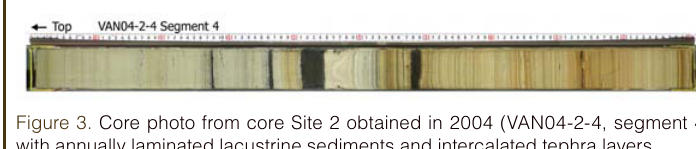
Figure 2. Stack (top) and part of Geochirp Profile GeoB04-007 (bottom) across the Tat-Van Basin. The ages for the ash layers are taken from Landmann et al. (1996). See Fig. 1 for location of the profile and Fig. 3 for sediment core VAN04-02.